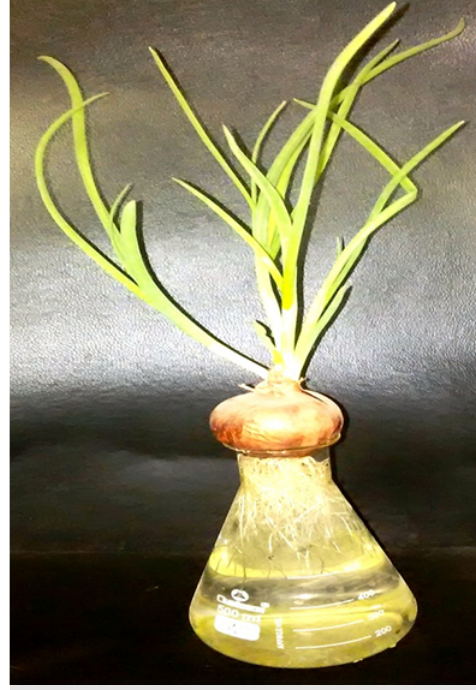
Fig. 1 Sprouting of the ‘Agrifound light red’ cul- tivar of A. cepa in moist